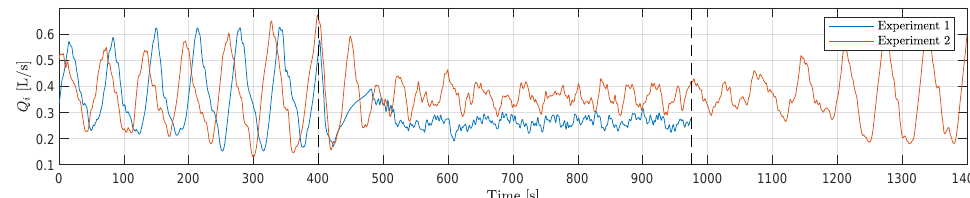
Figure 8. Flow entering the hydrocyclone during both experiments.